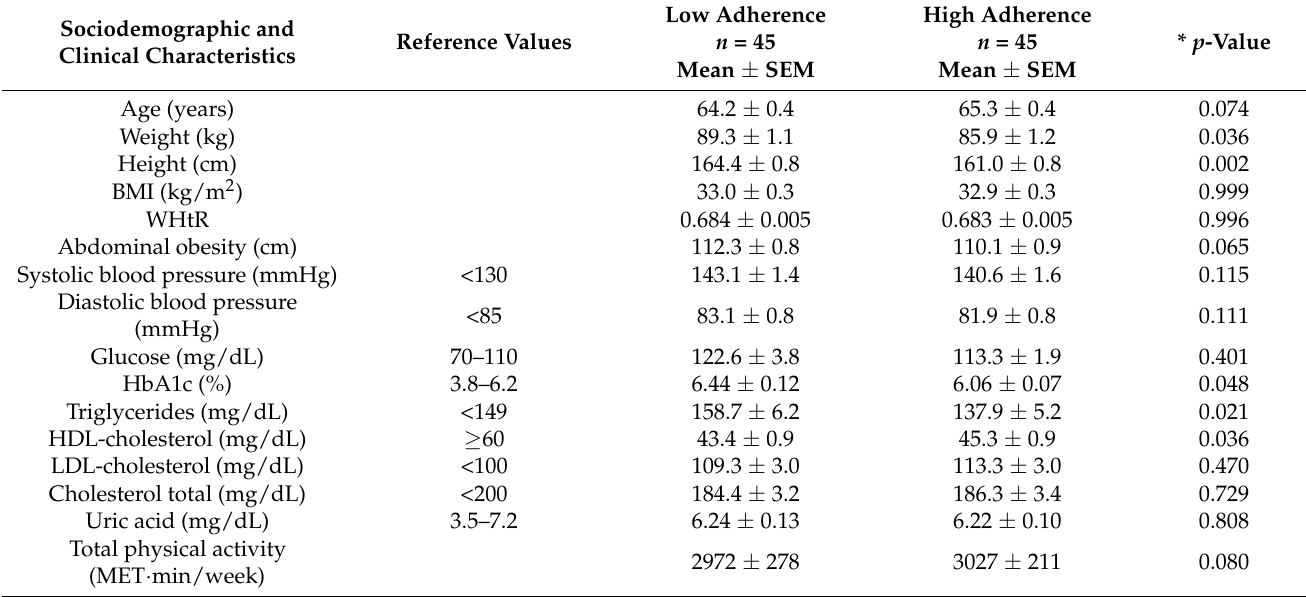
Table 1. Characteristics of participants according to adherence to median values of adherence to the Mediterranean diet pattern.